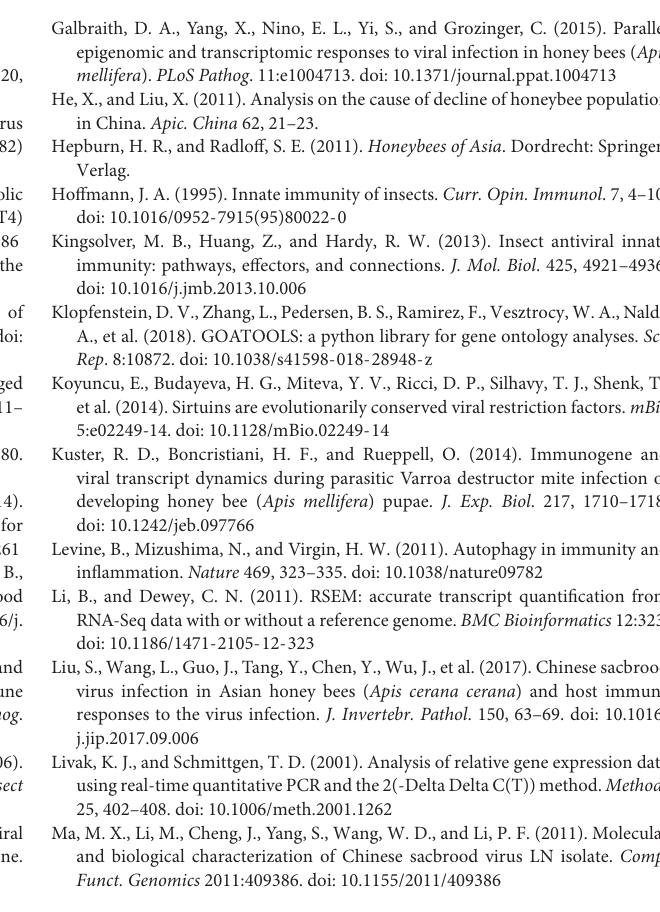
Supplementary Table 2 | Data quality control. Supplementary Table 3 | Correlation coefficient of samples. Supplementary Table 4 | Expression level of host differentially expressed genes. Supplementary Table 5 | GO enrichment of host differentially expressed genes. Supplementary Table 6 | KEGG enrichment of host differentially expressed genes. Supplementary Table 7 | KEGG energy metabolism of differentially expressed genes. Supplementary Table 8 | Sirtuin pathway of host differentially expressed genes. Supplementary Table 9 | The primer of quantitative real-time